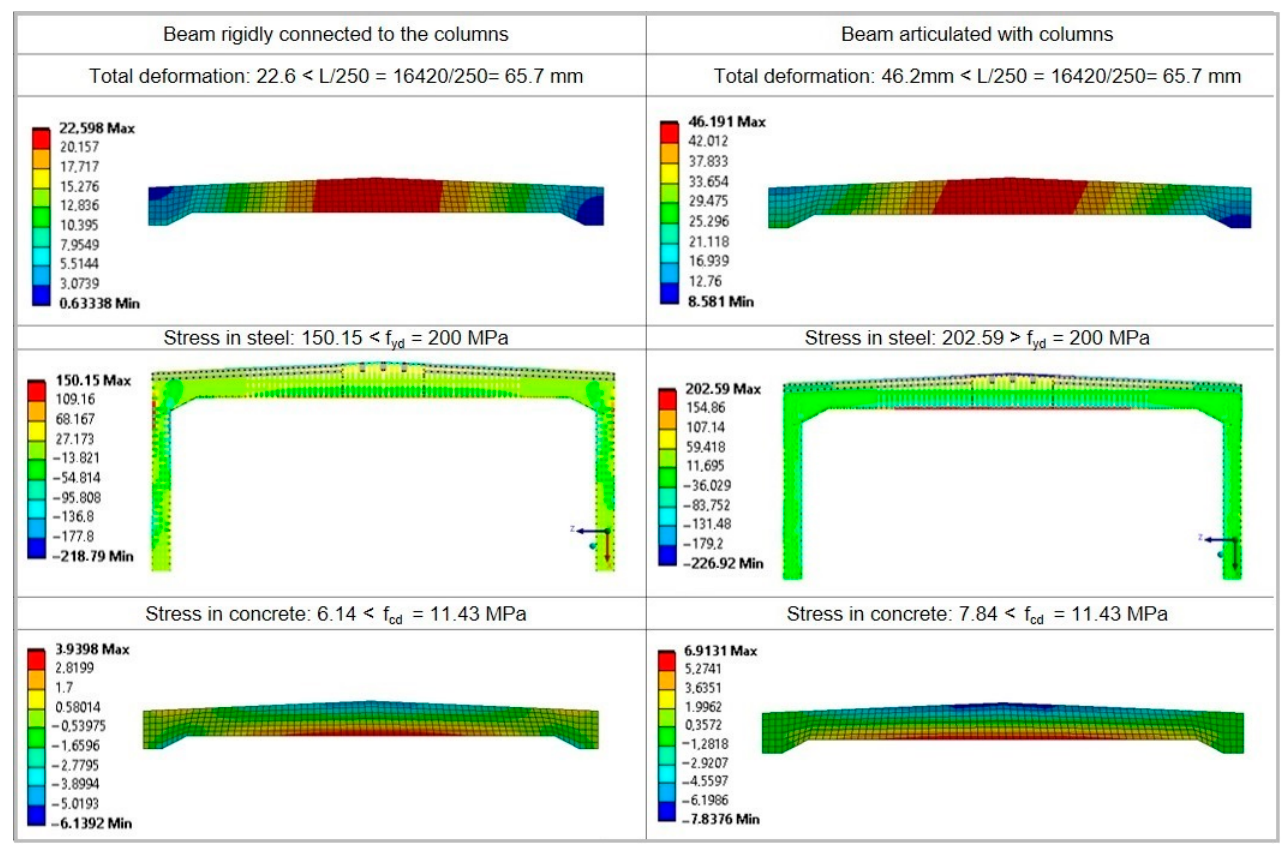
Figure 9. Static calculation results.